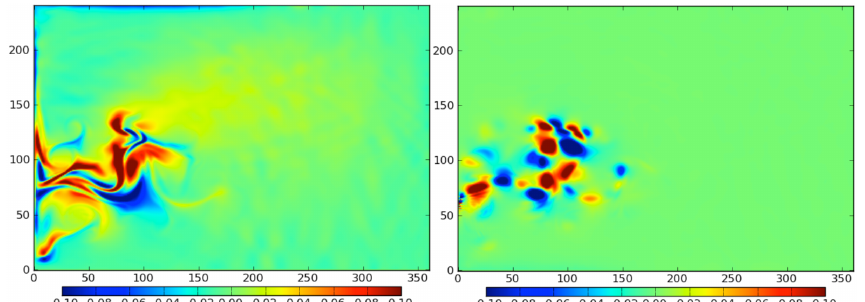
Figure 3. Sea surface height component of the leading forward (left) and backward (right) singular vectors for a SEABASS configuration at 1/12 ◦ and a 10-day window.